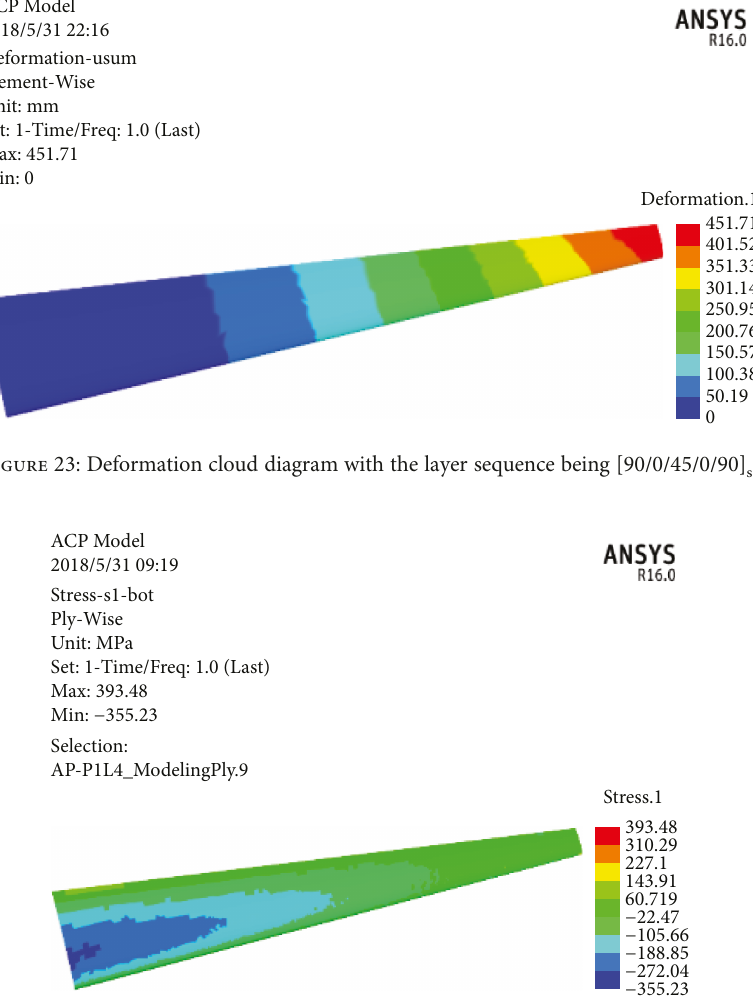
Figure 24: Stress cloud diagram of the upper wing with the layer sequence being [90/0/45/0/90]